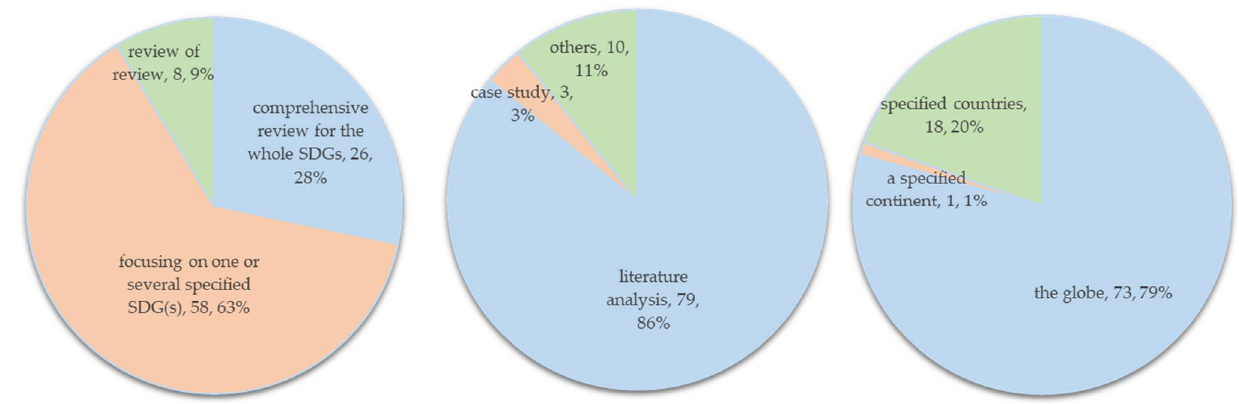
Figure 7. The major patterns of the SDG-related review papers in terms of scope, methodology, and geographic range, from left to